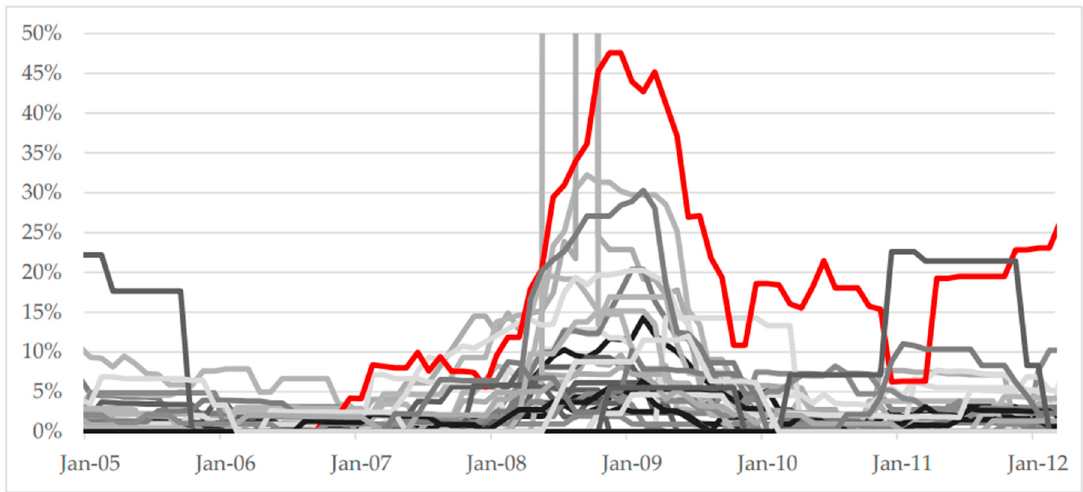
Figure 4. Sectoral default rates around the late 2000s’ deterioration in credit conditions. Source: Author’s calculations and Moody’s. Note that the exhibit presents sectoral default rates for 33 non-financial corporate sectors. The vertical axis was deliberately limited to 50% to illustrate volatility within and across sectors relative to lower default rates in some time periods. The “media and publications” sector is highlighted in red, as it was the first sector that saw its default rate jump sharply during the course of 2007.